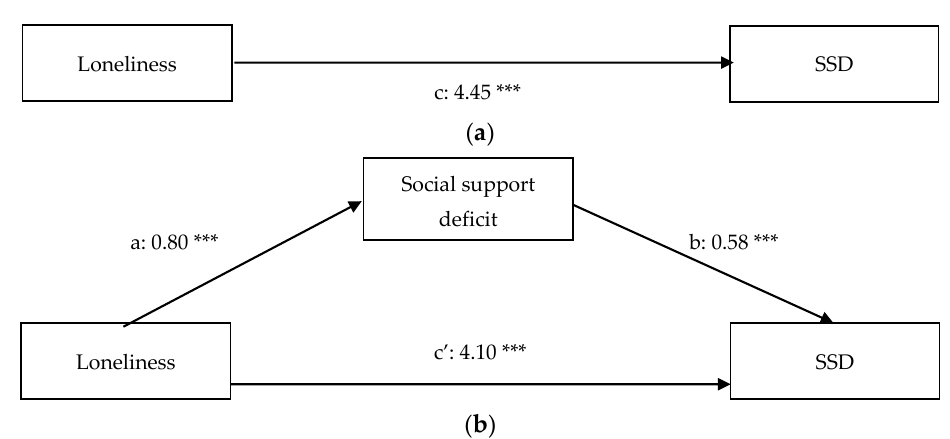
Figure 4. ( a ) Total relationship between loneliness and somatic symptom disorder (SSD). ( b ) Mediation of the relationship between loneliness and somatic symptom disorder (SSD). *** p < Table 2. Direct and indirect effects and 95% confidence intervals for the mediation analyses before inclusion of the covari- ates.